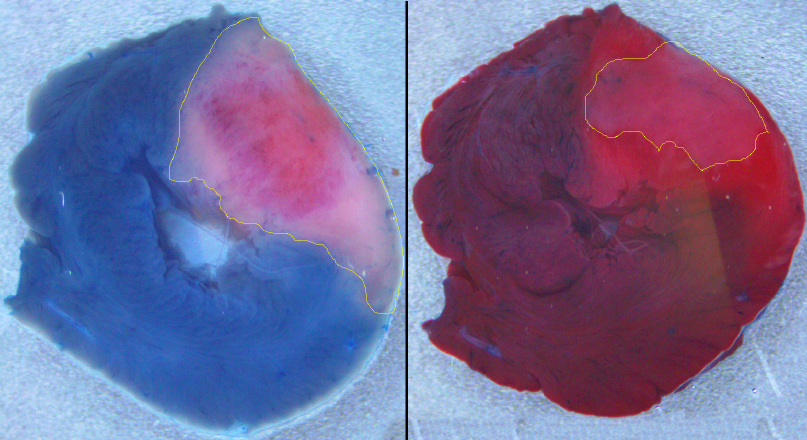
Figure 1. Experimental images of ischemia-reperfusion injury in the left ventricle of a rat. The left slice is stained by Evans Blue dye, revealing an unperfused area of necrosis and border zone colored in pink, in contrast with blue normal perfused tissue. The injury boundary is outlined with a yellow line. The right slice was incubated for 15 min in tetrazolium chloride solution (TTC), revealing the necrosis area of light pink color outlined in yellow, in contrast with viable TTC-positive myocardium colored in dark